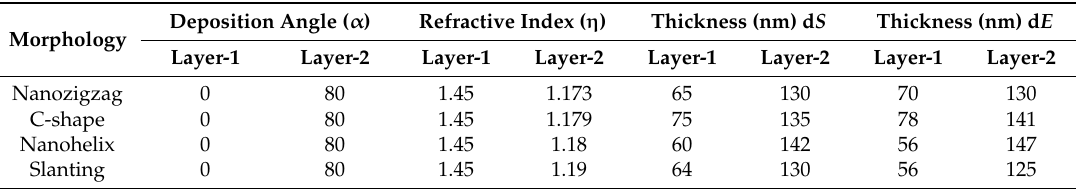
Table 1. Bilayer SiO 2 AR coating fabrication parameters.